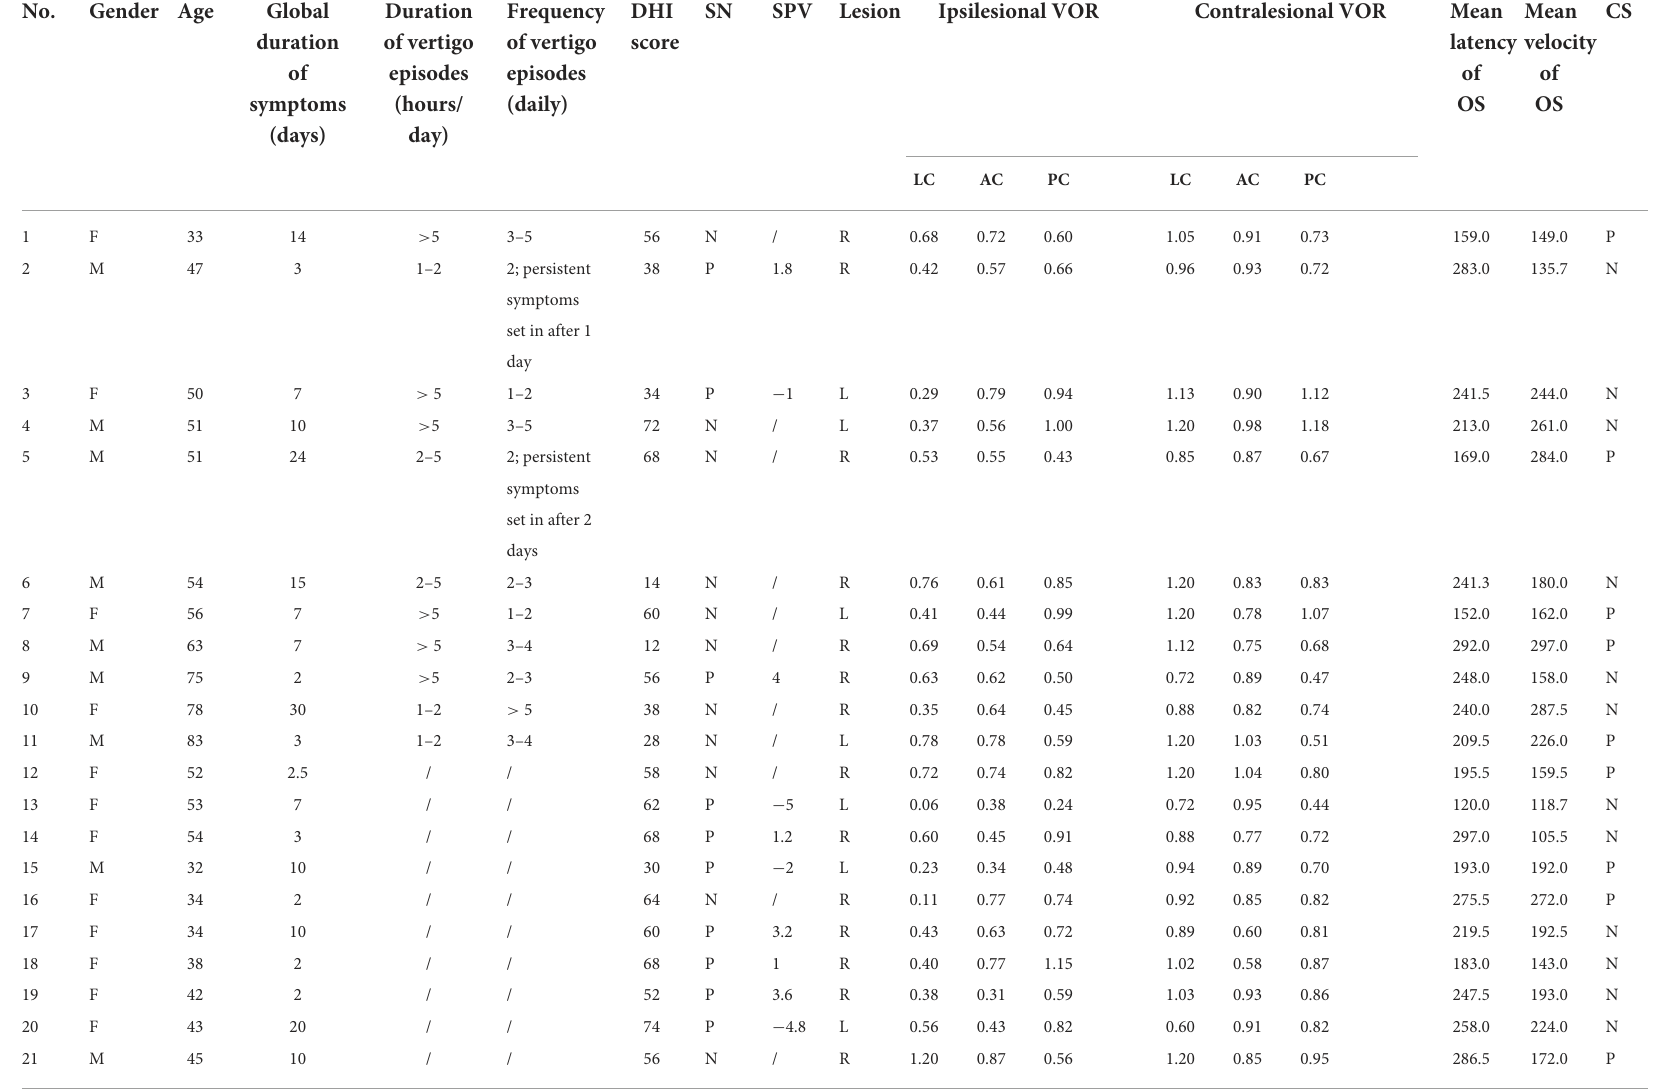
TABLE 1 Demographic, clinical characteristics and vHIT results of the 58 VN patients.